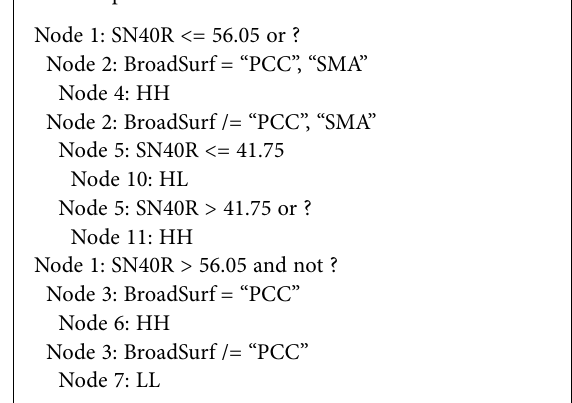
GUIDE classification tree with estimated priors and unit misclassification costs. At each intermediate node, an ob- servation goes to the left branch if and only if the condi- tion is satisfied. The symbol ‘ £ *’ denotes ‘ £ or missing’. Set fied/sample size beside each